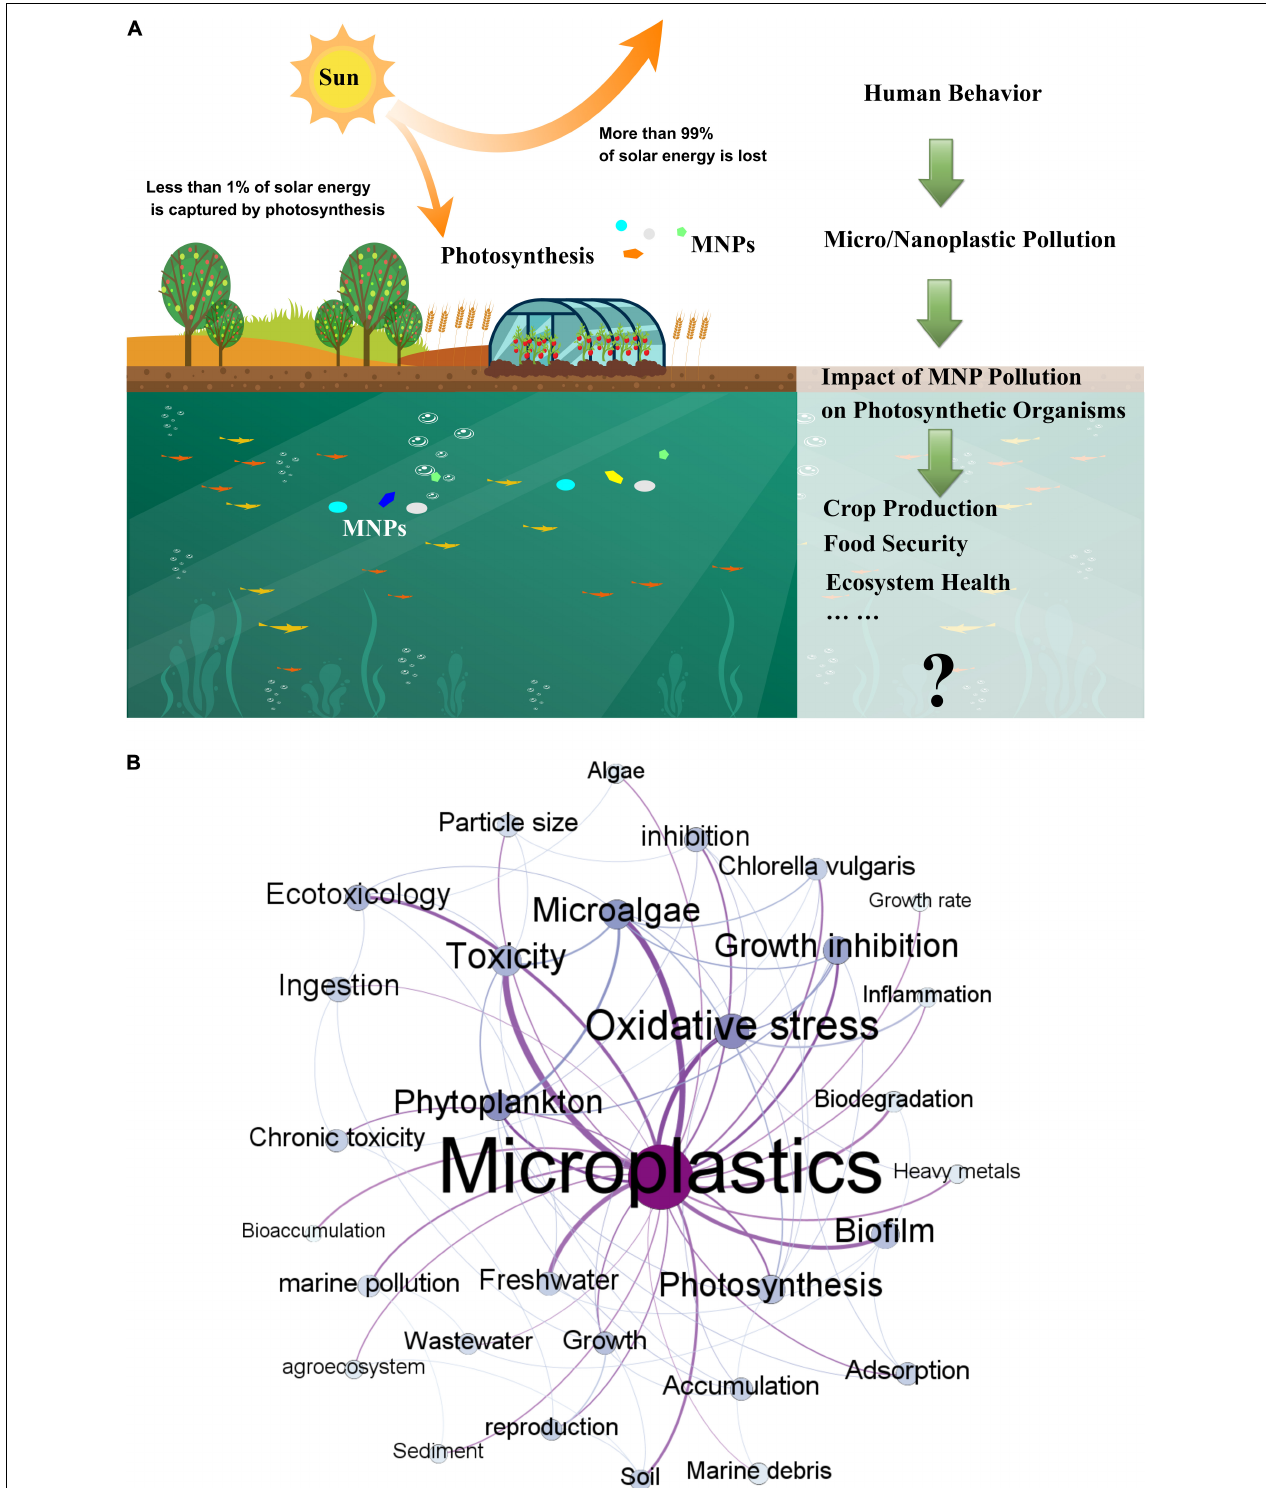
FIGURE 1 | (A) Schematic of the importance of study of impact of MPs on photosynthetic organisms. (B) Co-occurrence network analysis of keywords in MPs publications. Each keyword on the map is displayed as a node, with size determined by the occurrence. Keyword relationships are shown as edges of varying thickness determined by the